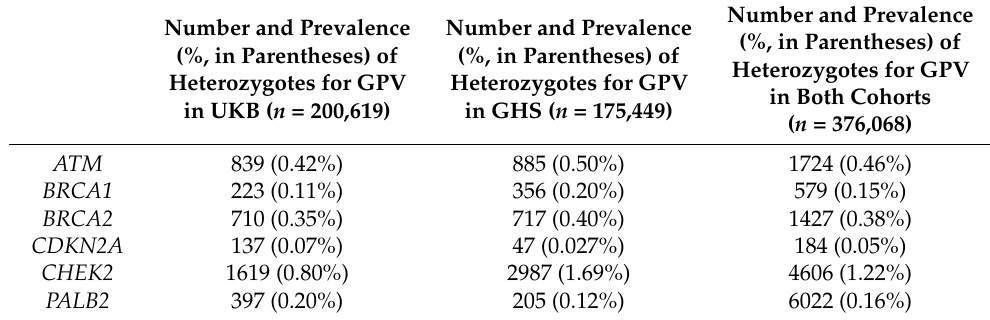
Table 2. Frequency of germline pathogenic variants in participants with pancreatic cancer. Both Astiazaran- UKB ( n = 417) GHS ( n = 592) Cohorts Symonds ( n = 1009) et al., 2021 Number of Frequency Number of Frequency PDAC of GPVs in PDAC of GPVs in Cumulative Cumulative Participants PDAC Participants PDAC Frequency Frequency with GPVs Participants with GPVs Participants ALL P/LP 25